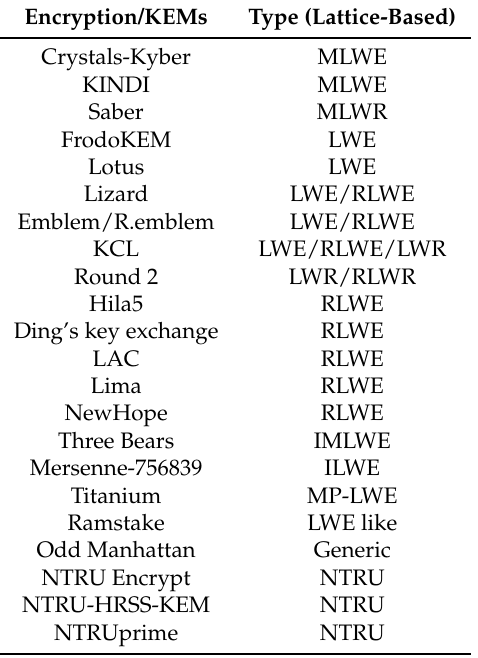
Table 1. List of lattice-based encryption and key encapsulation mechanisms (KEMs) [4]. Encryption/KEMs Type (Lattice-Based) Crystals-Kyber MLWE KINDI